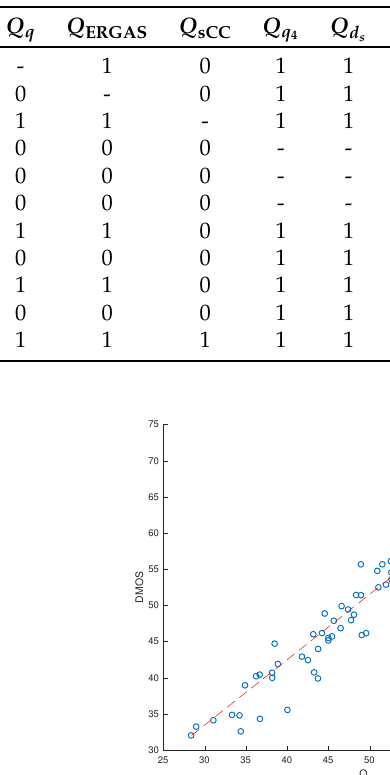
Table 20. Statistical significance matrix of SRCC between DMOS and quality indices.